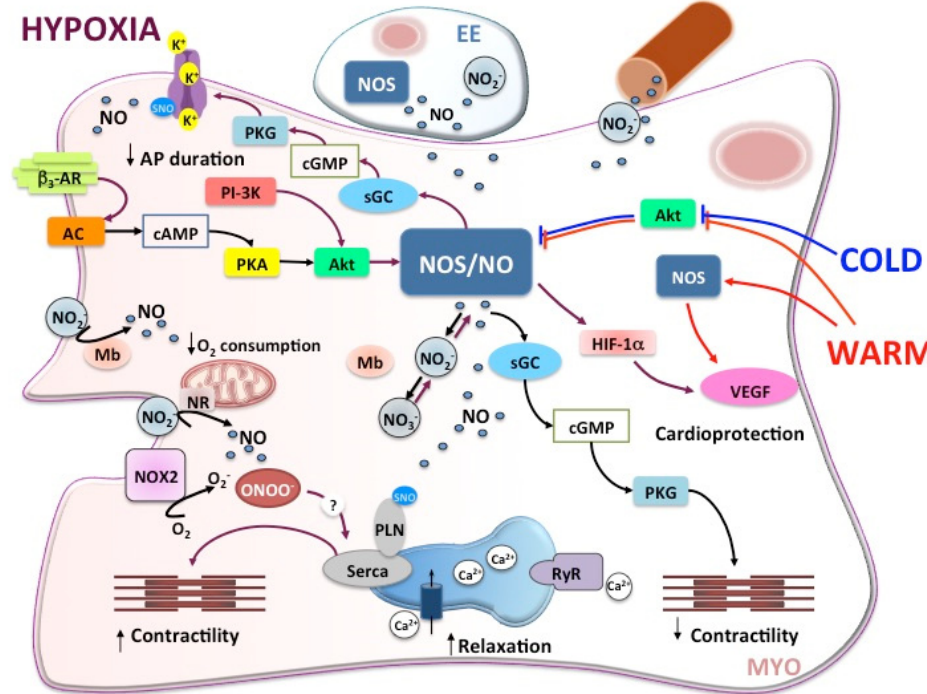
Figure 2. Schematic overview of the NOS/NO-mediated intracellular pathways activated in fish cardiomyocyte (MYO) under basal (black arrows), and hypoxic (violet arrows), and thermal stress (blue and red arrows). For details, see the text. AC, adenlylate cyclase; AKT, serine/threonine kinase 1; β 3-AR, beta 3 adrenoreceptor; cAMP, cyclic adenosine monophosphate; cGMP, cyclic guanosine monophosphate; EE, endocardial endothelium; HIF-1 α , hypoxia inducible